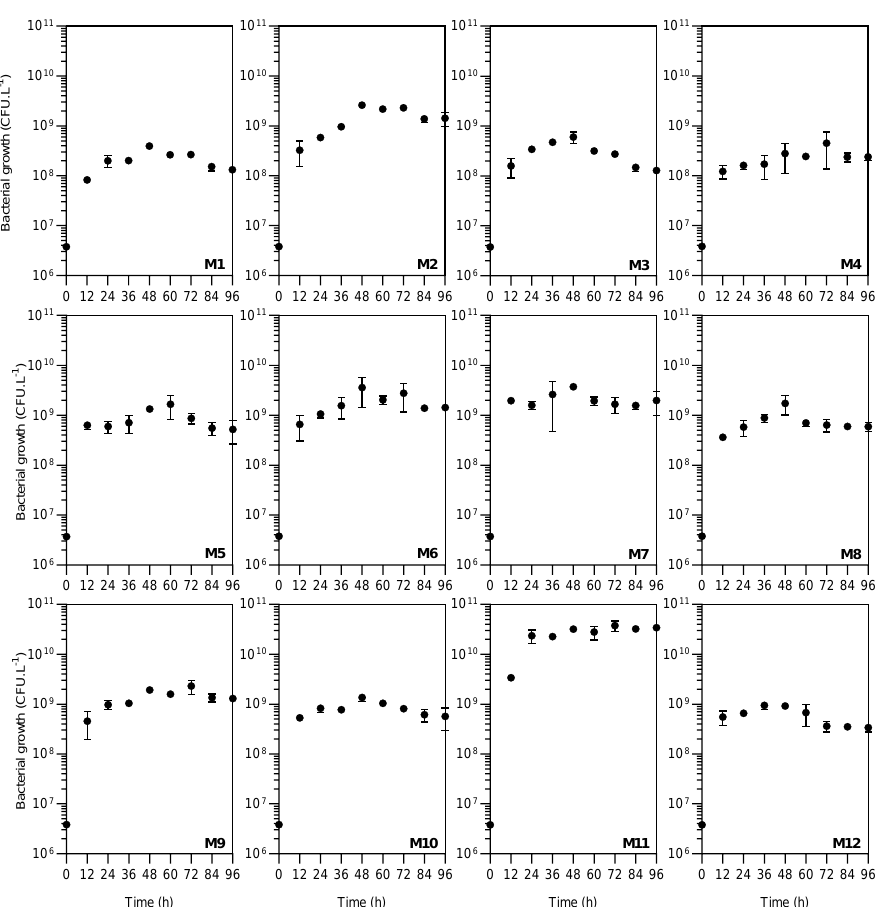
Figure 1. Growth kinetic profiles of Aeromonas caviae CHZ306 in the chitin-containing medium under different nitrogen supplementations (viz. M1–M12). M1 (ammonium sulfate), M2 (ammonium acetate), M3 (ammonium nitrate), M4 (urea), M5 (casaminoacids), M6 (meat extract), M7 (yeast extract), M8 (peptone Bacto), M9 (peptone A), M10 (peptone G), M11 (corn-steep solids), and M12 (tryptone). All data represent the mean ± standard deviation (sd).